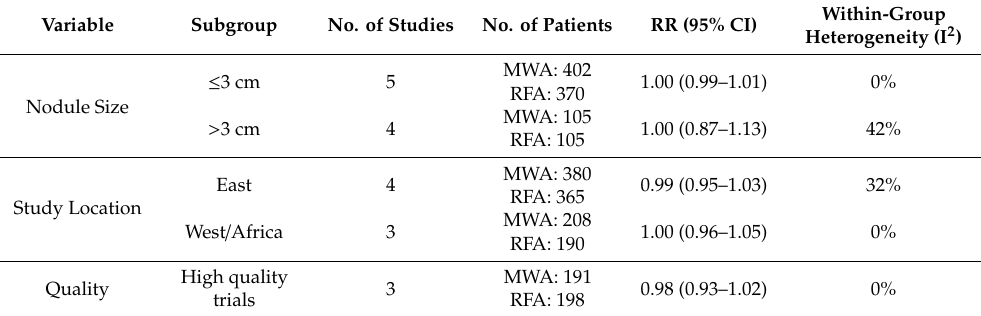
Table 2. Subgroup and sensitivity analysis concerning the rate of complete ablation.